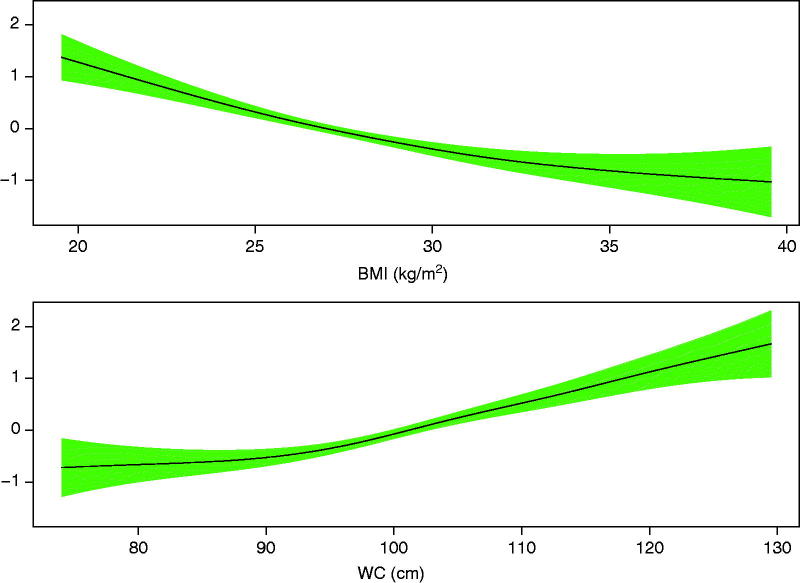
Logit of mortality risk with 95% confidence intervals versus BMI and WC, adjusted for each other.